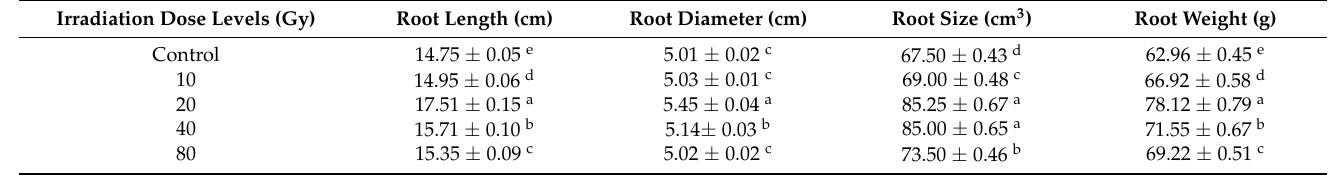
Table 3. Root characteristics of red radish plants affected by gamma rays at various dose